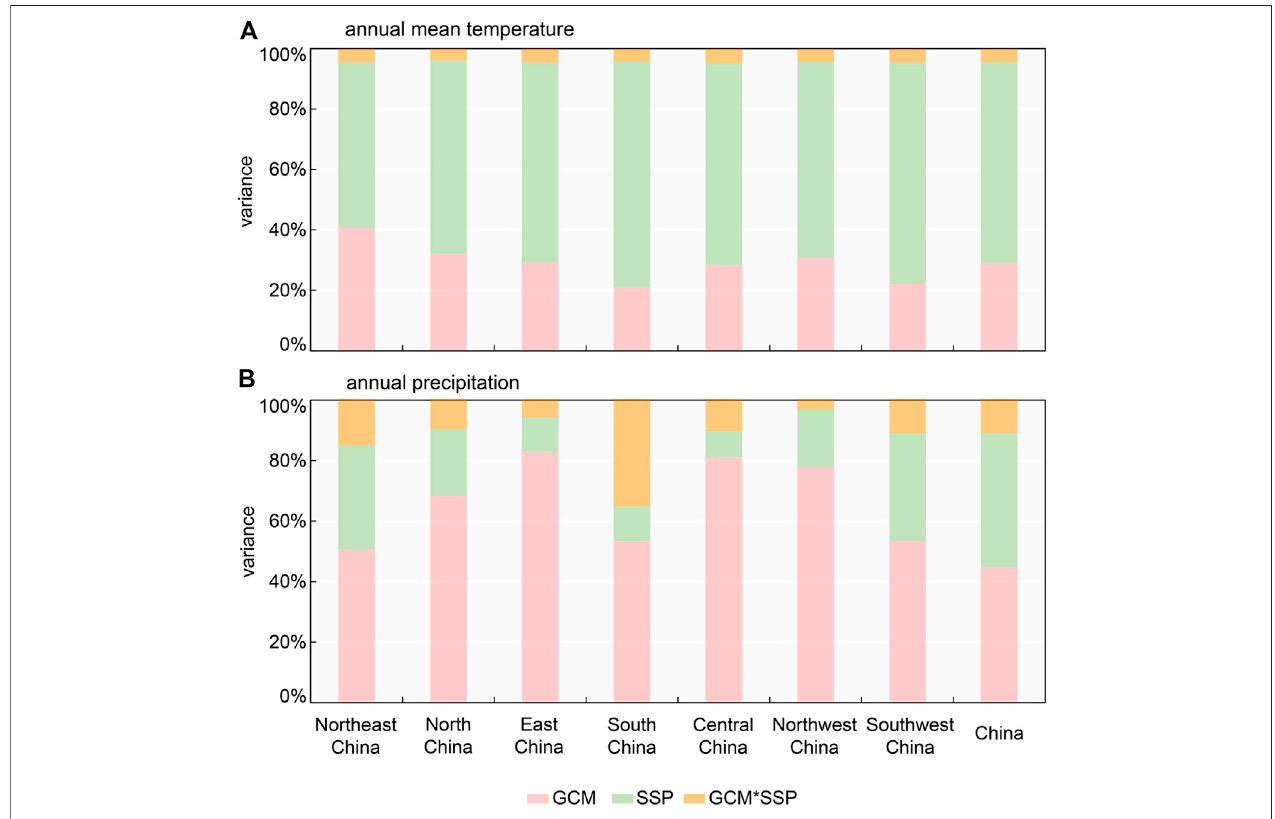
FIGURE 7 | The main contribution (and their interactions) of GCM and SSP to the sources of uncertainty on annual precipitation and annual mean temperature projections over China and seven sub-regions.